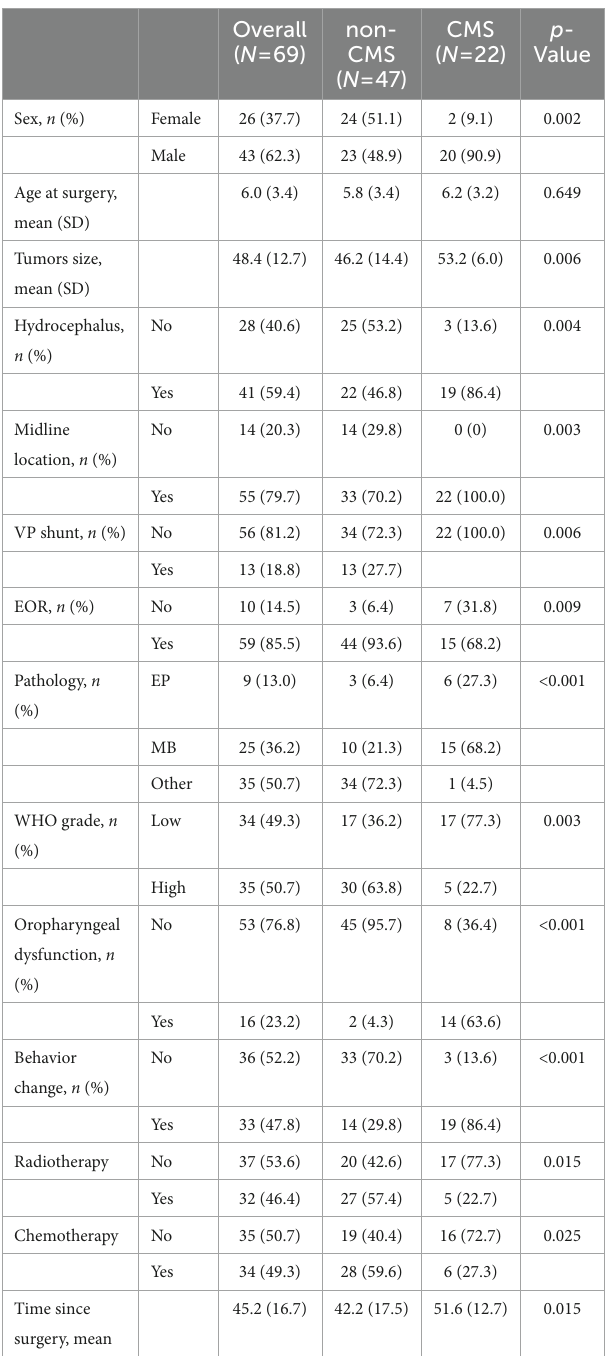
TABLE 1 CMS patient’s characteristics. TABLE 2 Patients clinical